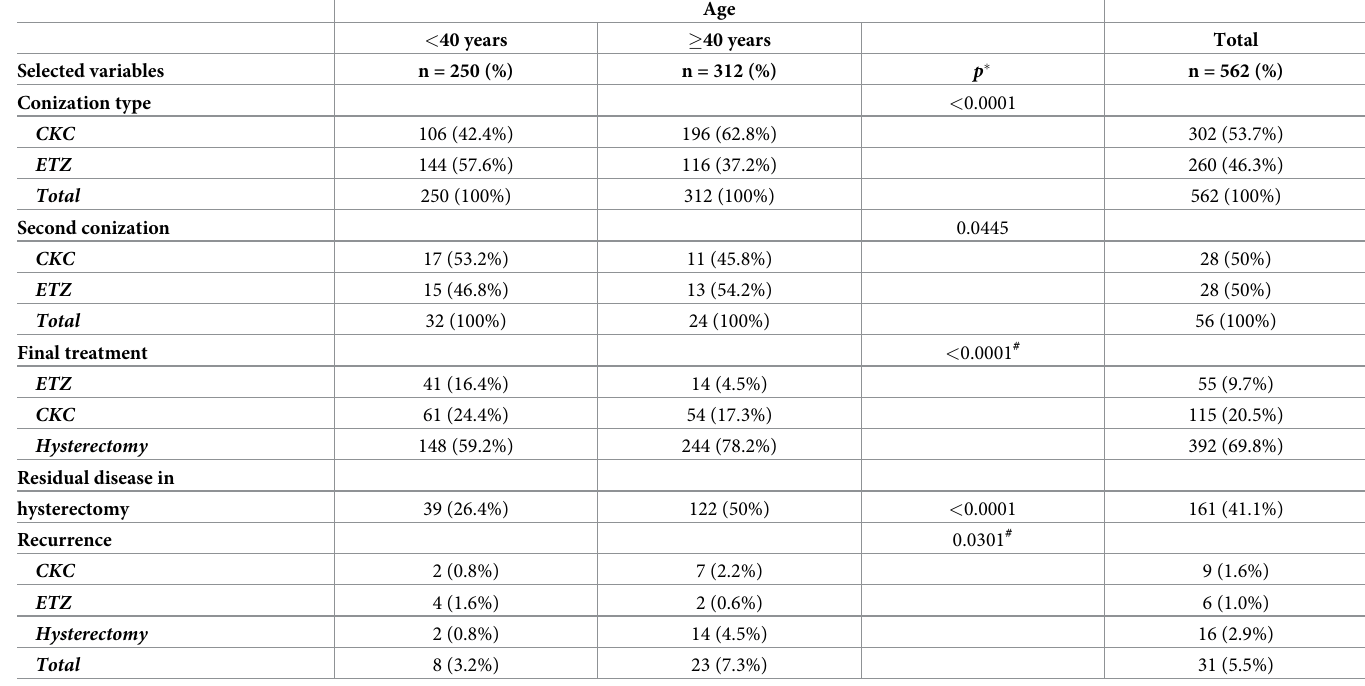
Table 1. Distribution of 562 women with microinvasive squamous cell carcinoma of the cervix stage IA1 studied according to the conization type, final treatment method, residual disease, and recurrences, by age-group. Age < 40 years � 40 years